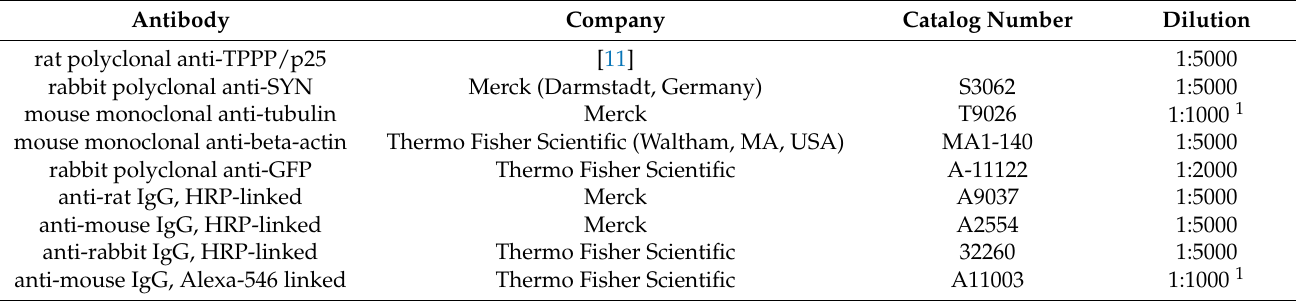
Table 1. Antibodies used in this